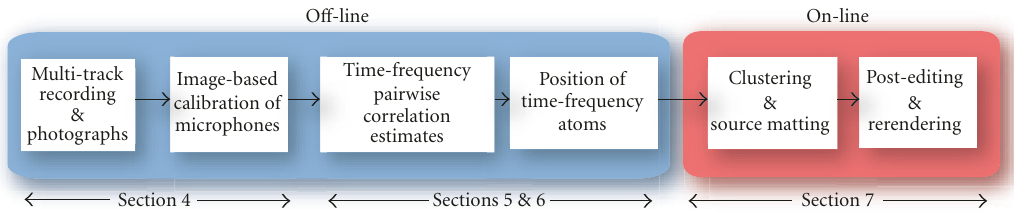
Figure 2: Overview of our pipeline. In an o ff -line phase, we first analyze multitrack recordings of a real-world environment to extract the location of various frequency subcomponents through time. At run time, we aggregate these estimates into a target number of clustered sound sources for which we reconstruct a corresponding signal. These sources can then be freely postedited and